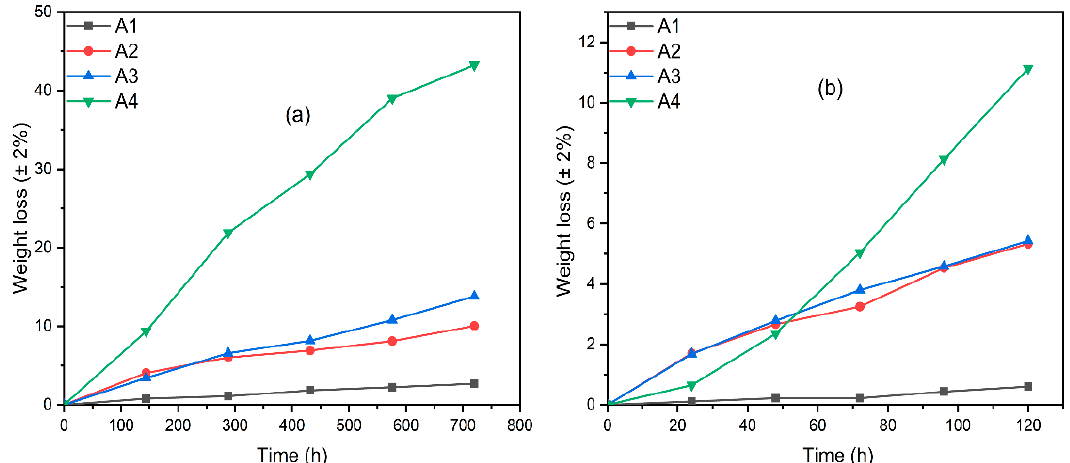
Figure 2. Changes in weight loss of different glass samples in deionized water ( a ) and in HCl solu- tion ( b ).